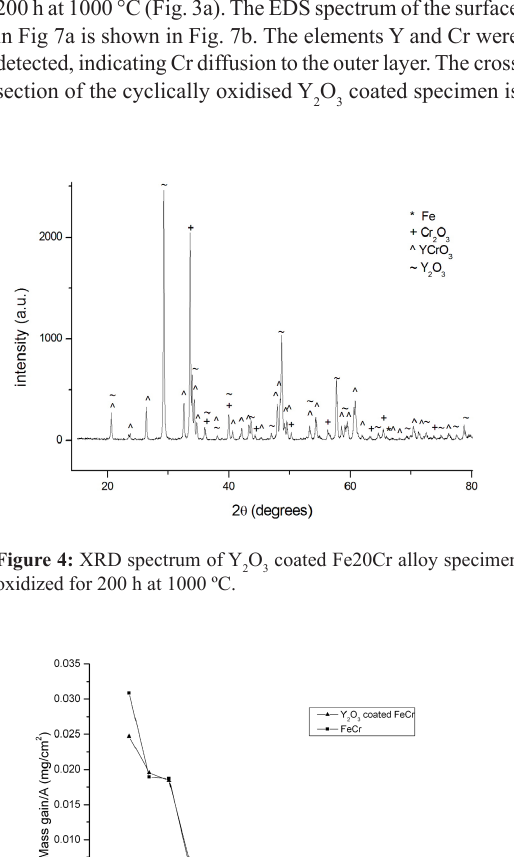
Table 4: EDS analysis results of regions 1, 2 and 3 in Fig.7c .